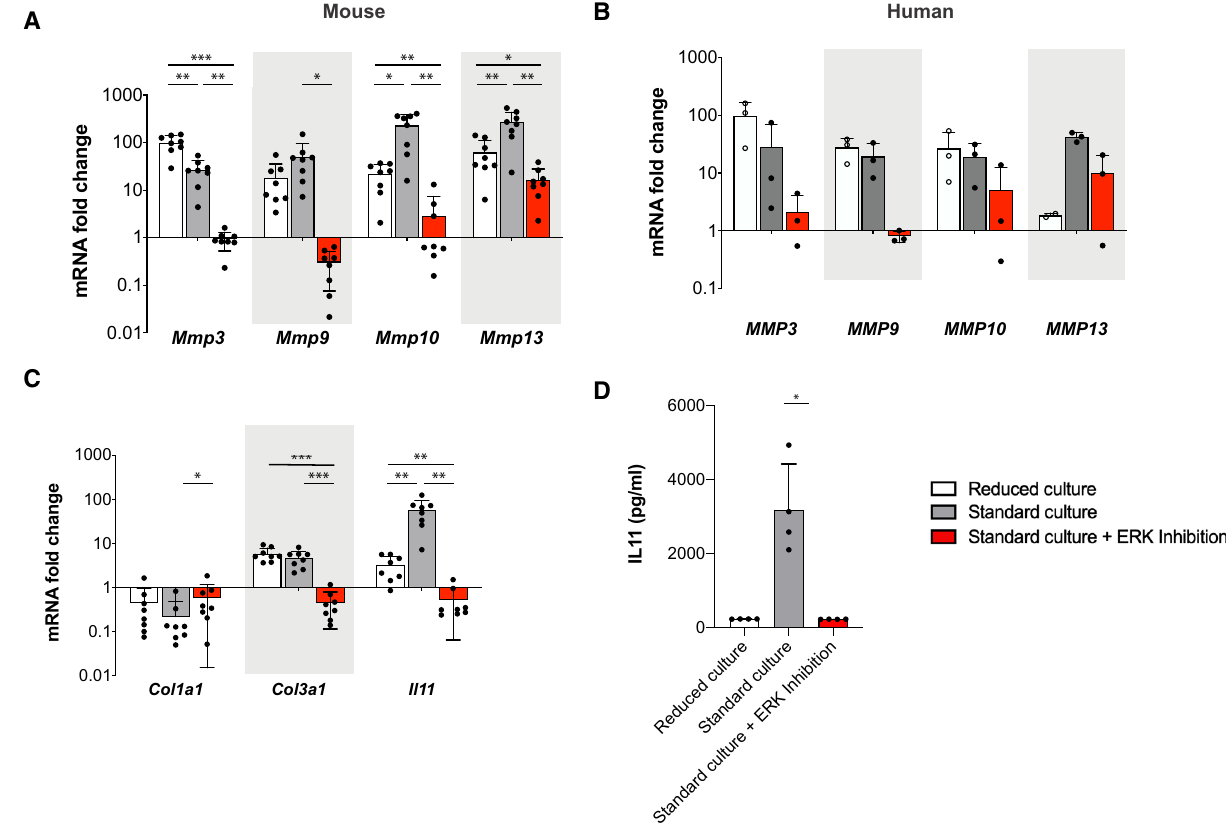
Figure 3. Inhibition of ERK 1/2 activity prevents the induction of matrix metalloproteinases, collagen type 3 and interleukin 11 gene expression in tendon explants. ( A ) Gene expression of murine Mmps after 12 days ex vivo culture. Data are normalized to 2 reference genes, N = 8. ( B ) Gene expression of human MMPs after 3-days ex vivo culture. Data are normalized to 2 reference genes, N = 3. ( C ) Gene expression of Col1a1, Col3a1 and Il11 in murine tissue after 12 days ex vivo culture. Data are normalized to 2 reference genes, N = 8. ( D ) Detection of IL11 protein levels in supernatants obtained from cultured tendon fascicles by ELISA, N = 4. Friedman test with Dunn’s multiple comparison test. Gene expression data is plotted on a logarithmic scale. GraphPad Prism (version 8.4.3) was used to perform statistical analyses and generate the figures. Box plots (25th and 75th percentiles) with whiskers (5th and 95th percentiles), median (line) and mean (+). Bar plots represent mean values + SD. All statistical tests unless otherwise stated: Repeated measures ANOVA with Tukey’s multiple comparisons test with * p < 0.05, **p < 0.01, ***p <